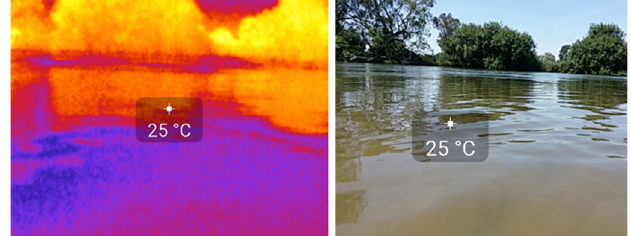
Fig. 1. A thermal image (left) and visible image (right) showing the ability of nearly smooth river water to re fl ect incident thermal radiation produced from warmer trees on the river bank to produce well de fi ned thermal